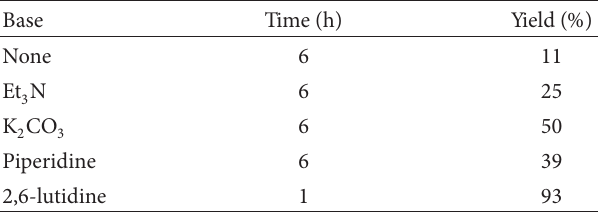
T 3: Sulfonation of 5a to 6a (second reaction in Scheme 3) with CuI, but screened for different bases under ultrasound